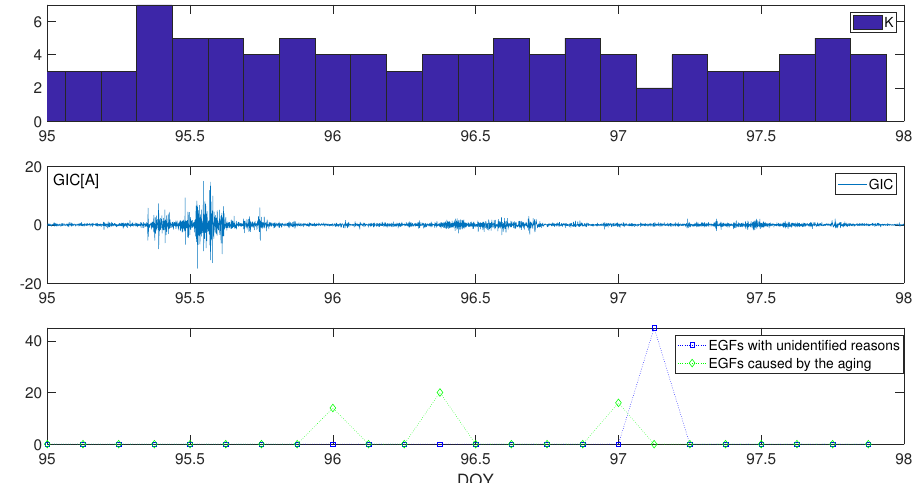
Figure 2. K index from Belsk (3-h resolution), computed geomagnetically induced currents (1-min resolution) and electrical grids failures (EGFs) (3-h resolution) around 5–6 April 2010 (95–96 doy). On the horizontal axis is marked the